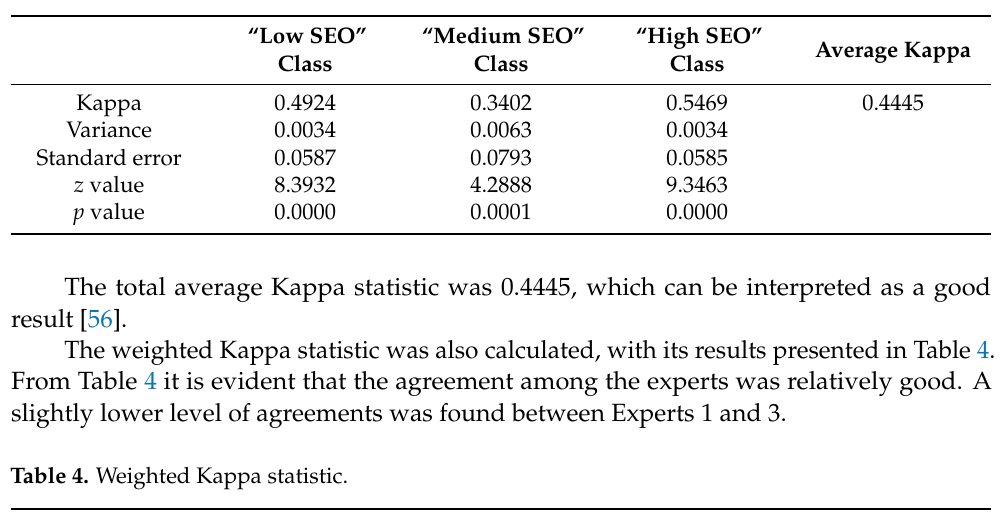
Table 3. Fleiss Kappa statistic for three experts on 600 instances of the data set.